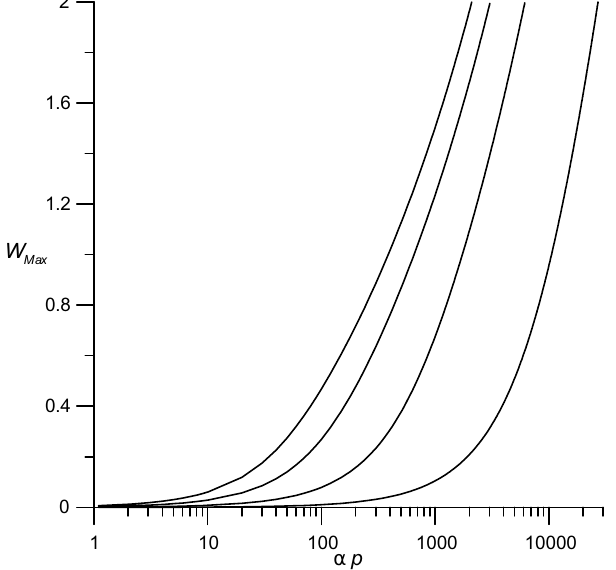
Fig. 8. Variation of the maximum nondimensional deflection W Max with the applied nondimensional load αp for simply supported-simply supported plates of inner radii b = 0 . 1 , 0 . 3 , 0 . 5 , and 0 . 7 .